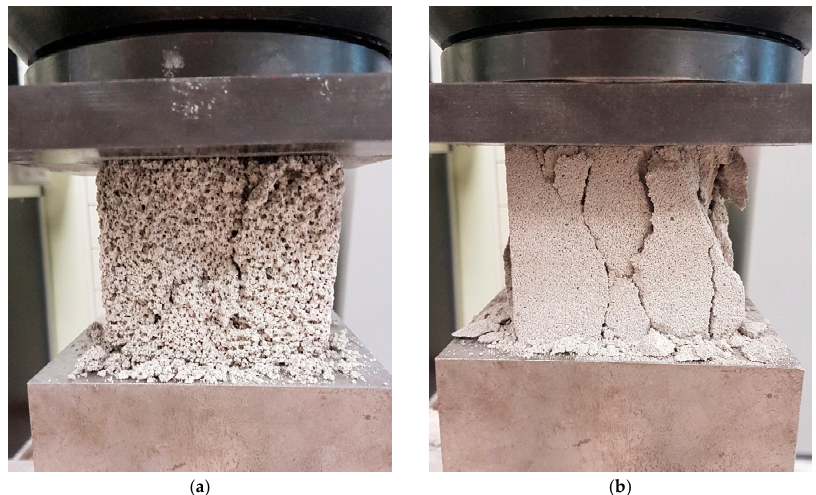
Figure 8. Image of destruction of foamed concrete with density of around: ( a ) 500 kg/m 3 , ( b ) 700 kg/m 3 .